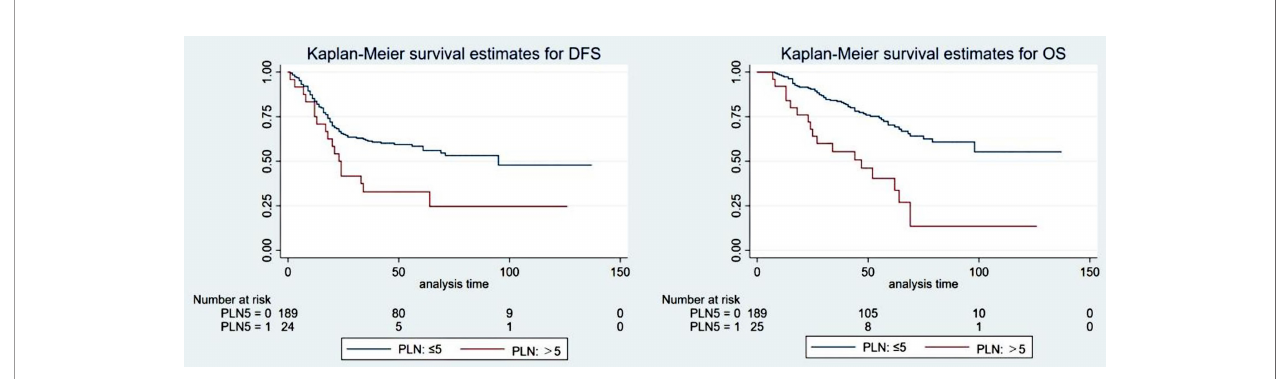
FIGURE 3 | The survival curve of the ypT1-4N+ group when the optimal cutoff value of the positive lymph nodes (PLNs) was